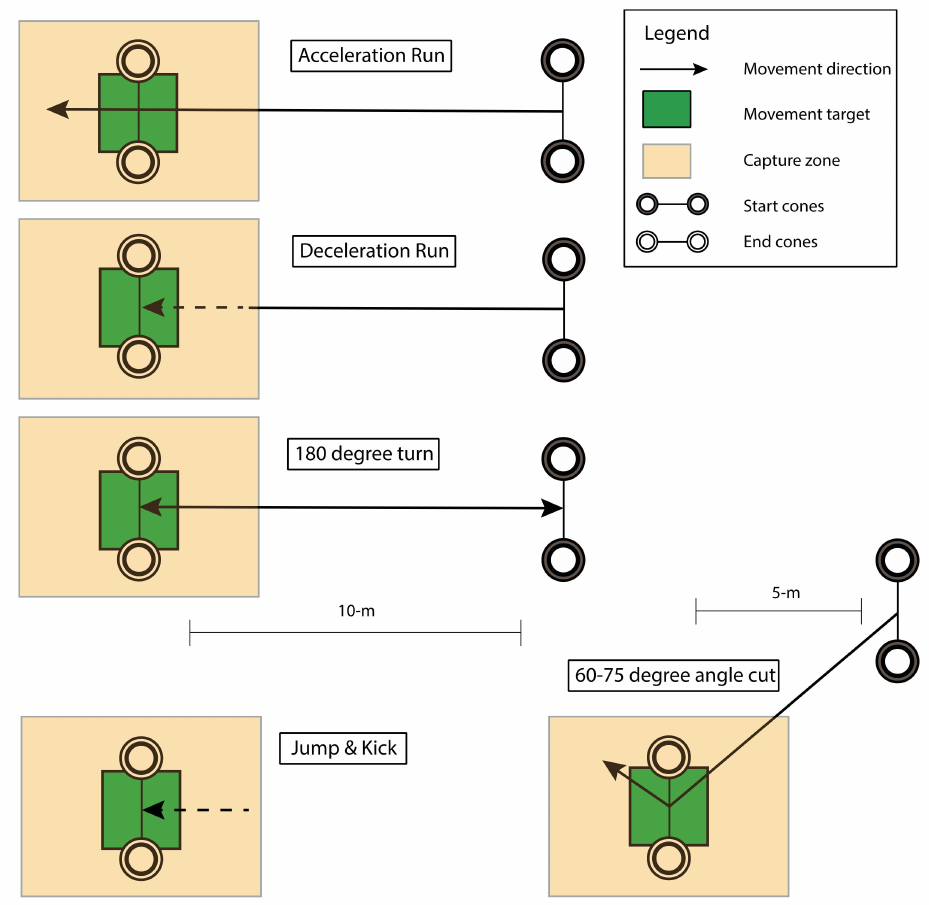
Figure 3. Football specific movements. Schematic representation of the performed football specific